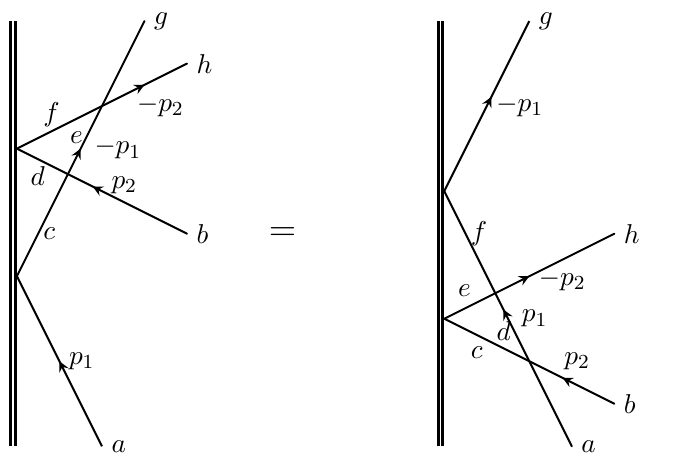
Figure 2 . Graphical representation of the boundary Yang-Baxter equation. a; b; c; d = 1 ; : : : ; 4 are (cid:13)avour indices while p 1 and p 2 are the magnon